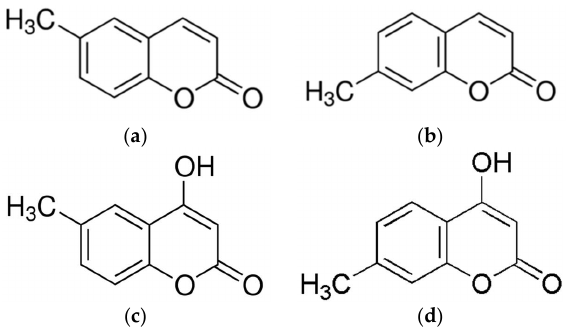
Figure 1. The chemical structure of ( a ) 6-methylcoumarin (6-MC), ( b ) 7-methylcoumarin (7-MC), ( c ) 4-hydroxy-6-methylcoumarin (4H-6-MC), and ( d ) 4-hydroxy-7-methylcoumarin (4H-7-MC).